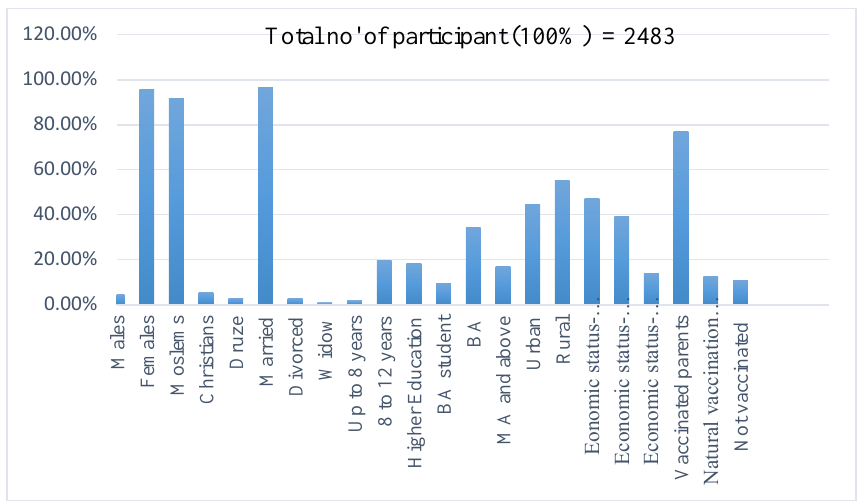
Figure 1. Demographic data of participants. Percent of each sector from total number of participants